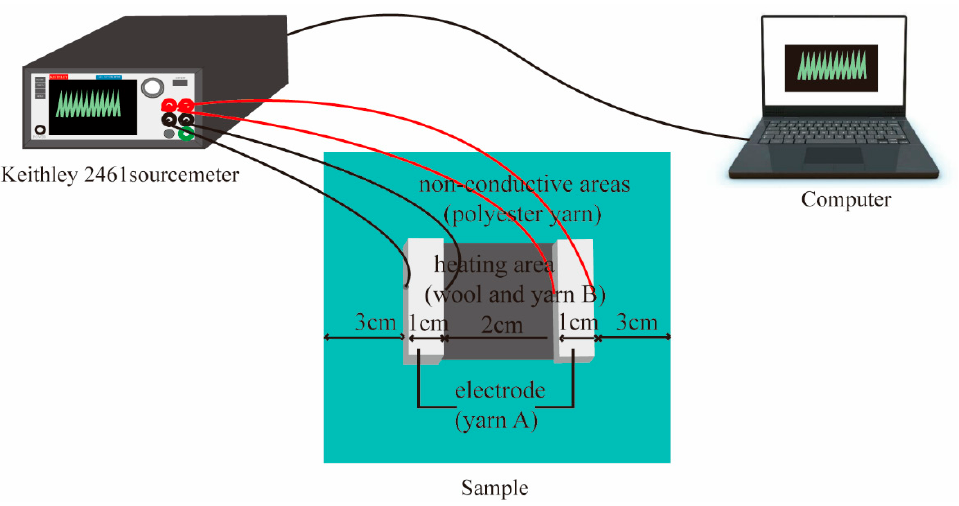
Figure 3. The tested device connections of the conductive fabric.